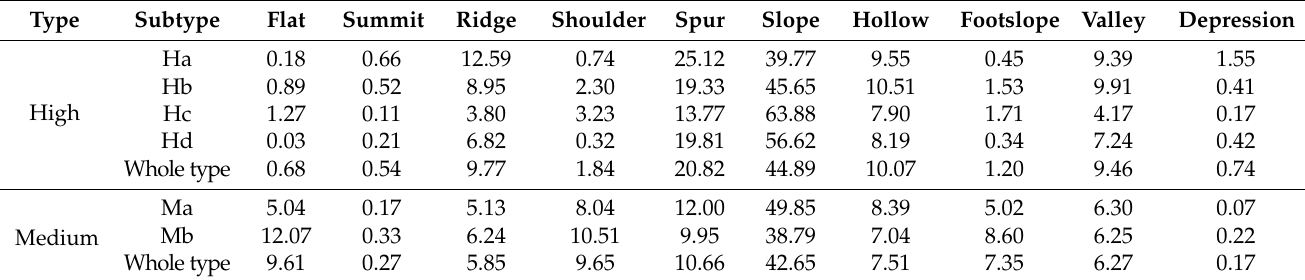
Table 3. Share (%) of geomorphon types in area of relief types and subtypes.